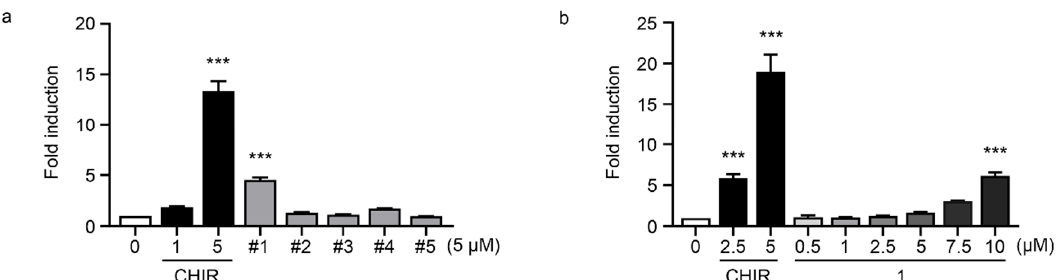
Figure 6. Activation of Wnt signaling pathway by cpd1. ( a ) Reporter analysis using HEK293 TOP flash cell line for measuring activities of GSK3 β inhibition on hit compounds. CHIR99021 is a GSK3 β inhibitor and used for positive control. Data are mean ± SEM (n = 3). p -value by one-way ANOVA (Tukey’s multiple comparisons) test. ( b ) An activation curve for determining the EC50 of cpd1 for TOP flash activity. Data are mean ± SEM (n = 3). p -value by one-way ANOVA (Tukey’s multiple comparisons) test. *** p < 0.001.